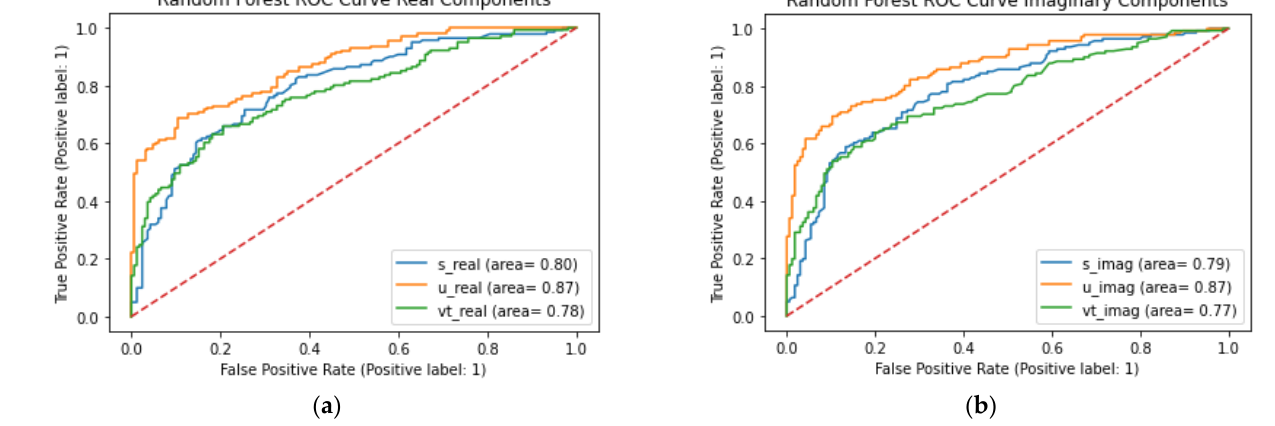
Figure 2. ROC curve of classification of healthy and COPD classifications of each signal component and SVD elements: ( a ) Chart of the ROC curve of the RFC for real components on the classification of Healthy and COPD in the first panel; ( b ) chart of the ROC curve of the RFC for imaginary components on the classification of Healthy and COPD.